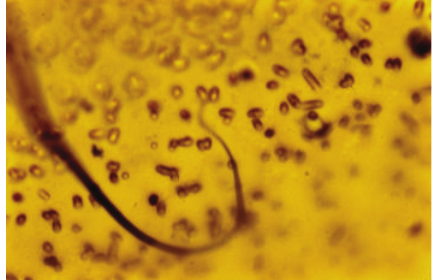
Figure 4: Tail of Acanthocheilonema (Dipetalonema) reconditum microfilaria ( ×